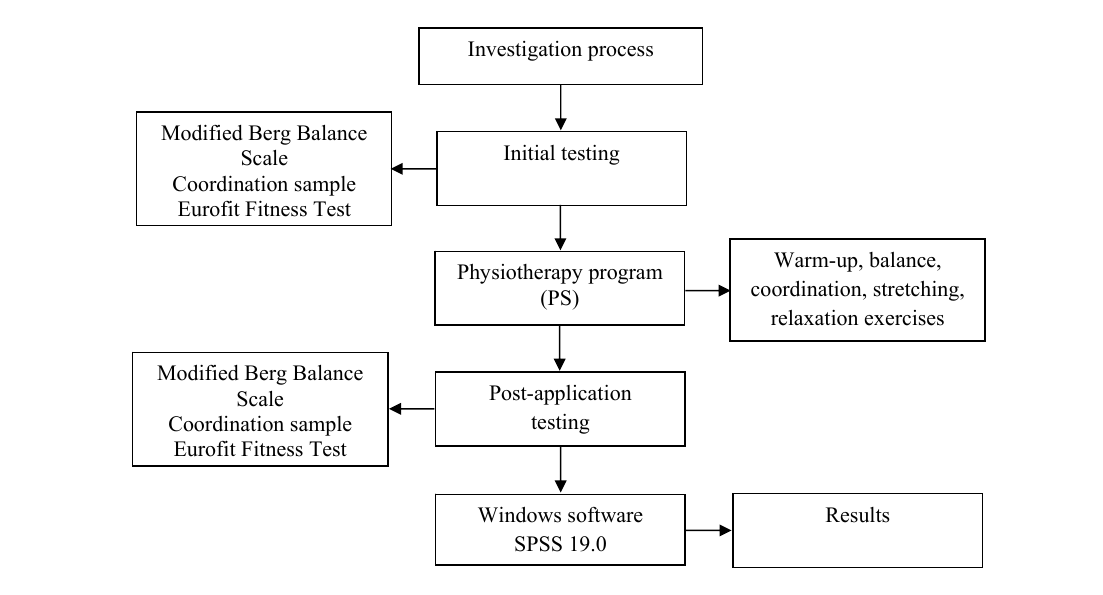
Figure. The scheme of the investigation process applied individually for each participant